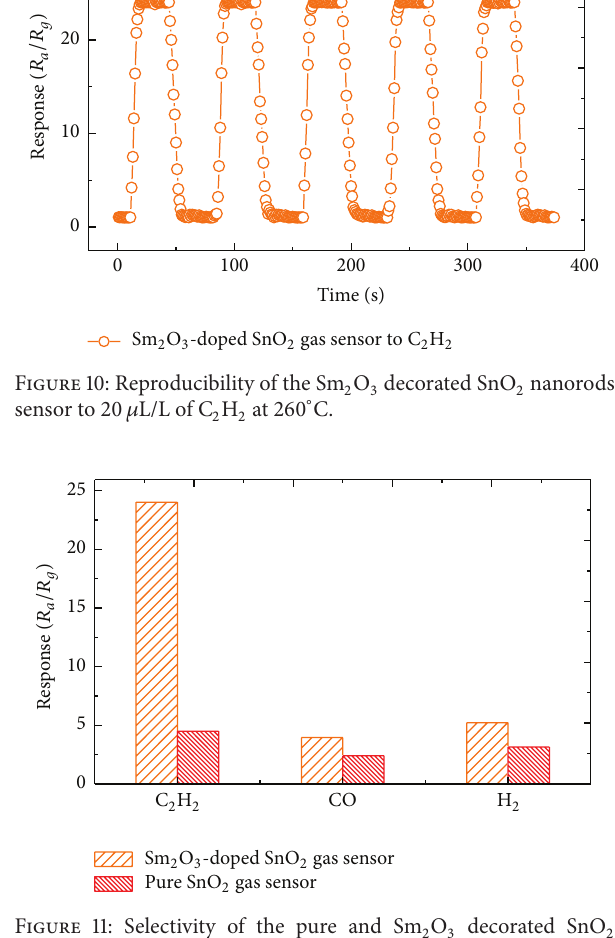
Figure 11: Selectivity of the pure and Sm 2 O 3 decorated SnO 2 nanorods sensors to 20 𝜇 L/L of C 2 H 2 , CO, and H 2 at 260 ∘ C. the carrier concentration and an increased sensor